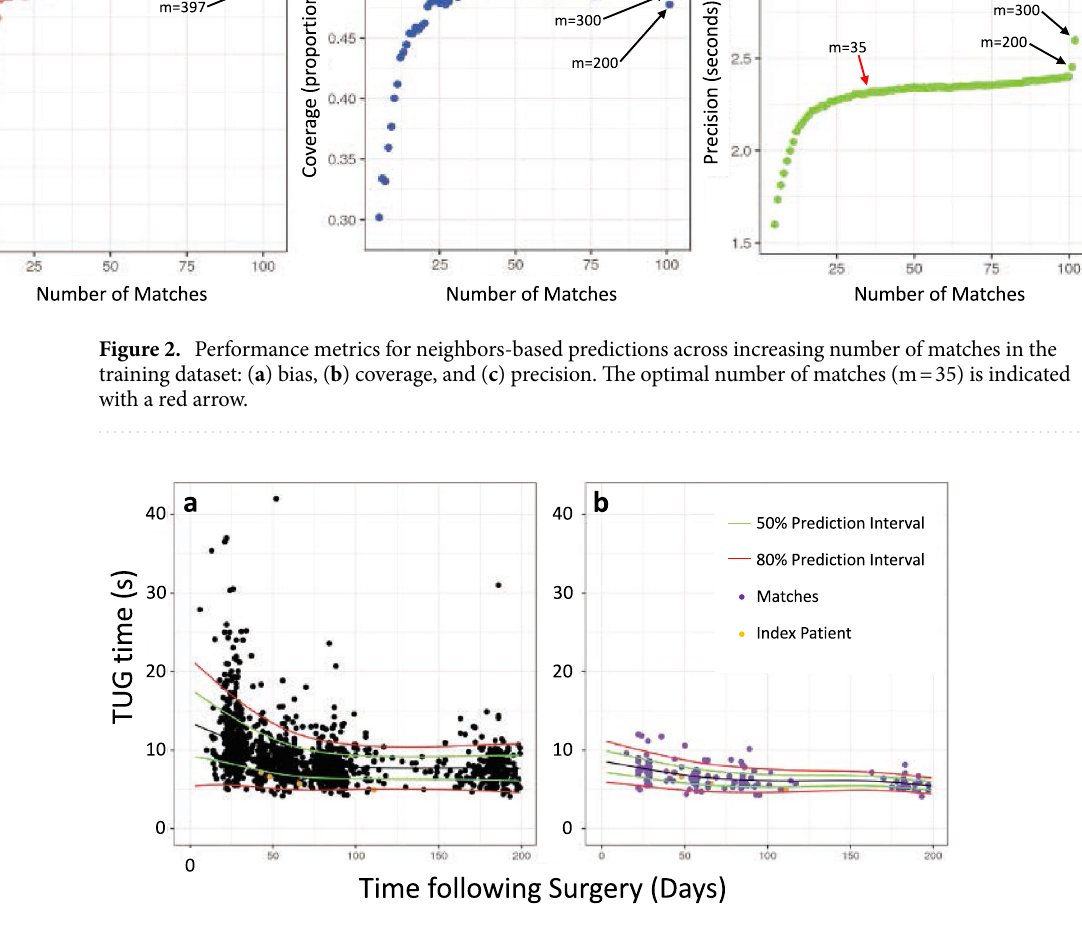
Figure 3. The 50% prediction interval (PI) for ( a ) the population-level estimate, is wider than the 50% prediction interval for ( b ) the neighbors-based prediction, for an example patient: a 55-year-old male with BMI of 30 kg/m 2 and preoperative TUG time of 8